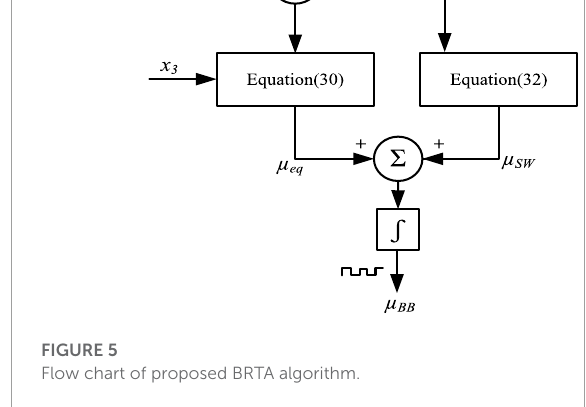
FIGURE 5 Flow chart of proposed BRTA